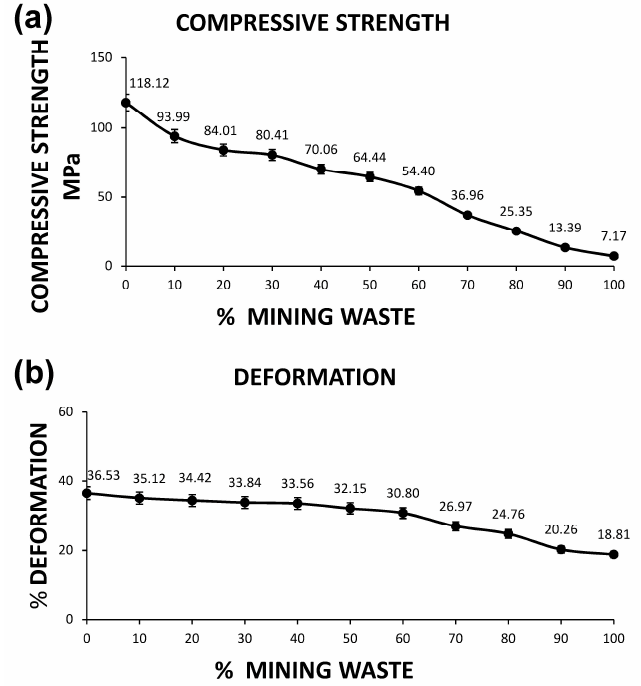
Figure 5. Physical properties of ceramic families with clay and mining residue after sintering ( a ) compressive strength and ( b ) deformation to breakage.